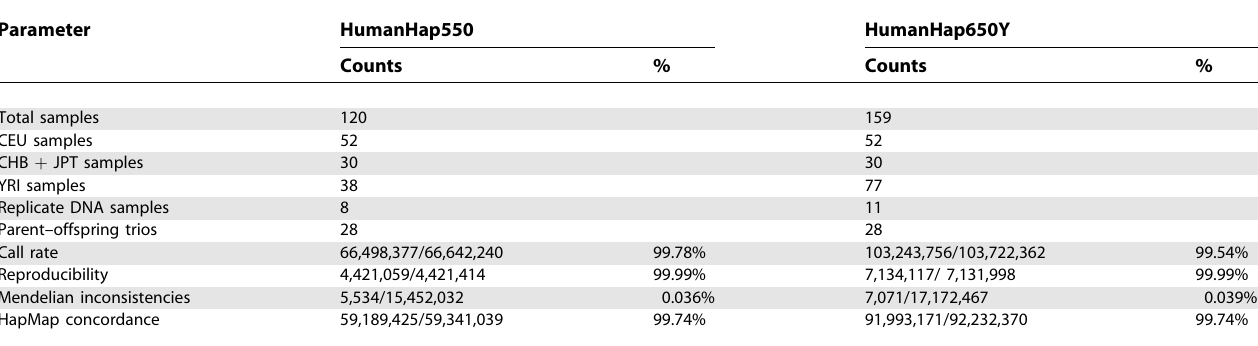
Table 4. HumanHap550 and HumanHap650Y Data Quality